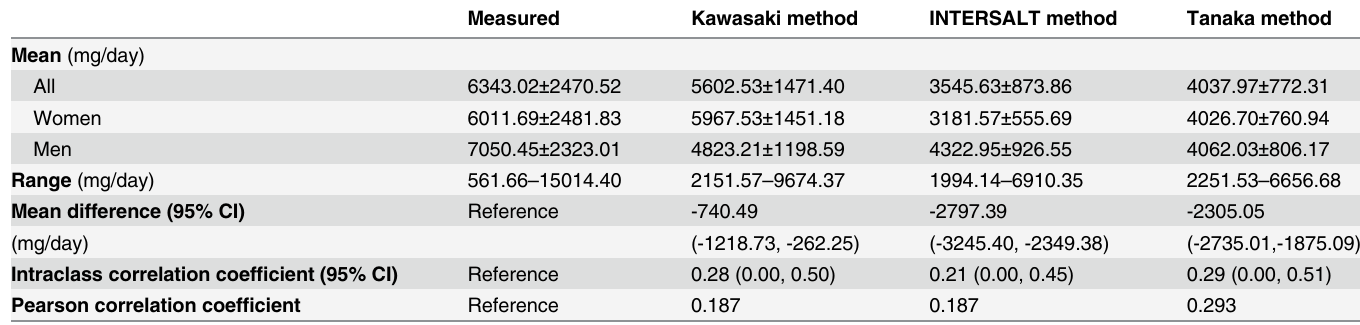
Table 3. Validity of three methods of estimation versus measured 24-h urinary sodium excretion in a sample of Chinese adults (n =